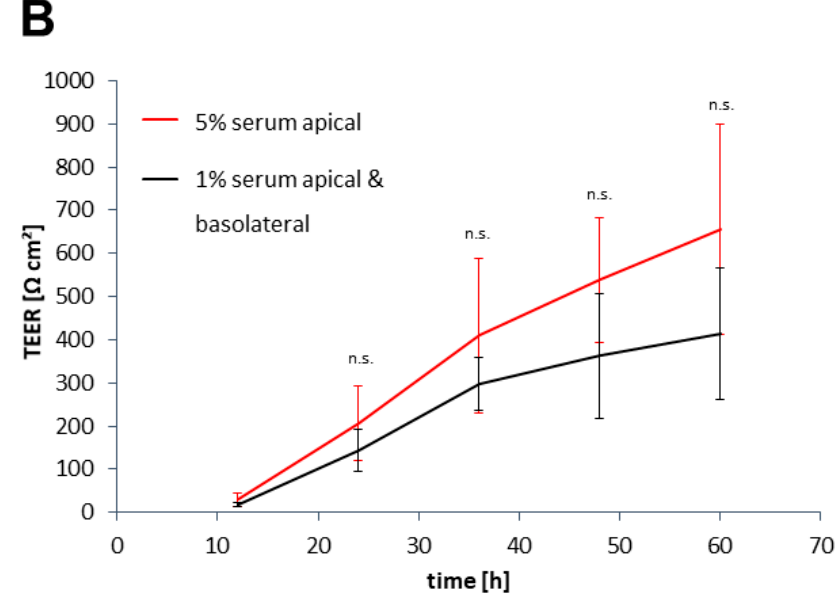
Figure 4. TEER development in reaction to a change in serum contents in the media. ( A ) pBCECs were seeded on collagen-coated Transwell ® inserts with 3.0 µ m pore size after isolation. TEER values were measured continuously. The medium was exchanged 24 h after seeding with either culture medium (serum-free, blue line) or culture medium with 5% FCS on the apical side and serum-free culture medium on the basolateral side (red line). Data shows mean ± S.D. at 12 h intervals for at least three biological replicates. ( B ) After 8 days of differentiation, hiPS-BCECs were seeded on collagen IV–fibronectin-coated membrane inserts with 3.0 µ m pore size and TEER was measured continuously. The medium was exchanged 24 h after seeding with either endothelial medium without growth factors (1% PDS, black line) or with enriched endothelial medium (5% PDS) on the apical side and endothelial medium without serum on the basolateral side (red line). Data shows mean ± S.D. at 12 h intervals for at least three biological replicates; n.s. p > 0.05.